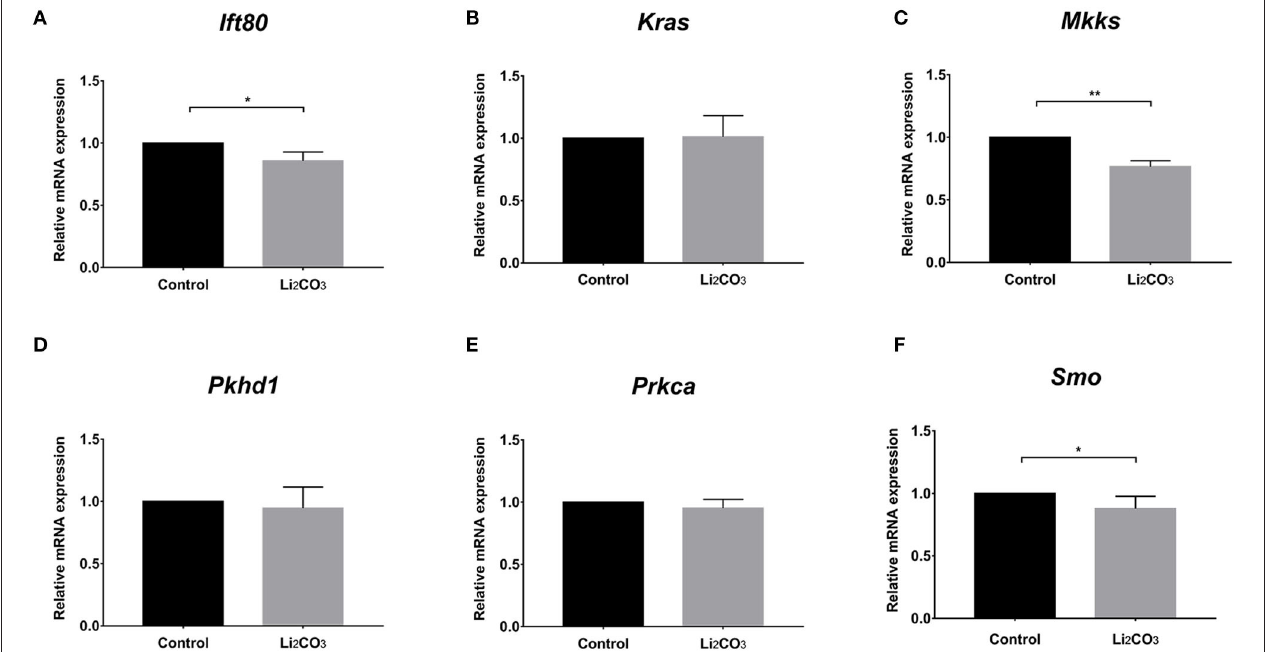
FIGURE 8 | The mRNA expressions of the cilia-related genes in the inositol deficieny cell model. (A–F) The mRNA expressions of Ift80 , Kras , Mkks , Pkhd1 , Prkca , Smo in NIH3T3 cells treated with or without 2mM Li 2 CO 3 for 24h. All the analysis in NIH3T3 cells were performed in three independent experiments ( n = 3). Each experiment was carried out in triplicate. * P < 0.05, ** P < 0.01 vs. Control group.